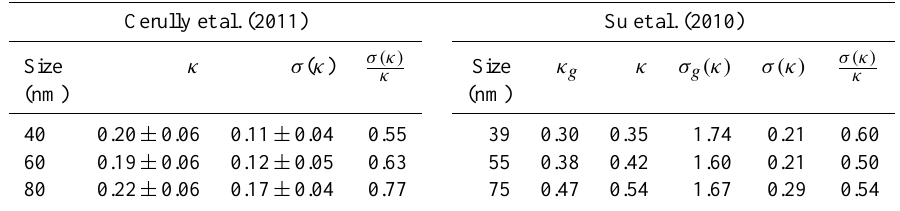
Table A2. Comparison of data with Su et al.